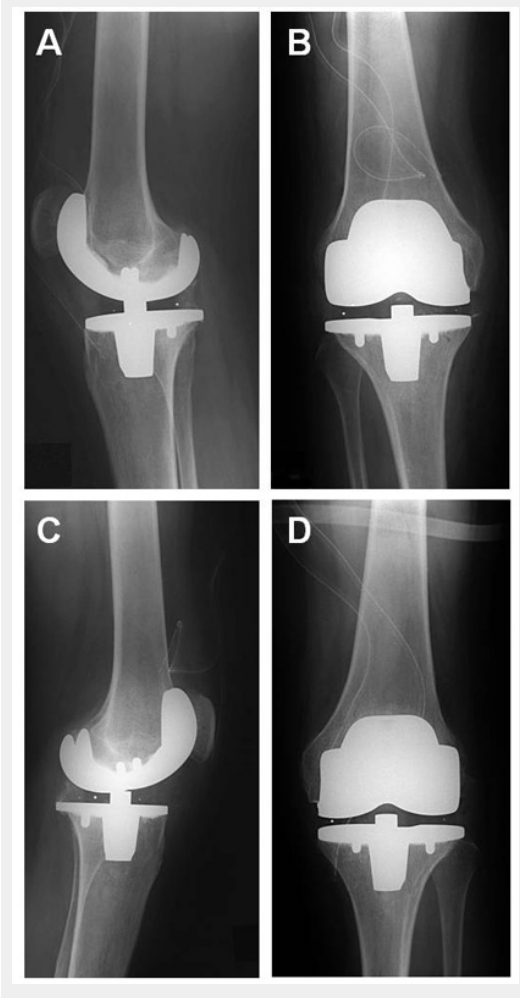
Preoperative x-rays of both knees. Arthrotic deformities in all three compartments of the knee joints could be observed. (a) Right knee lateral view (b) Right knee anterior-posterior view (c) Left knee lateral view (d) Left knee anterior-posterior view.